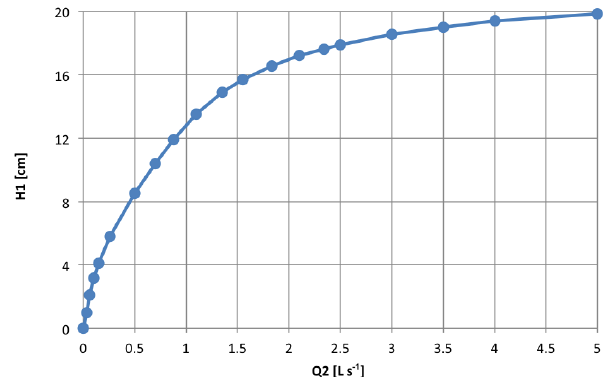
Figure 4. Relationship adjusted between the water level H 1 and the downstream discharge Q 2